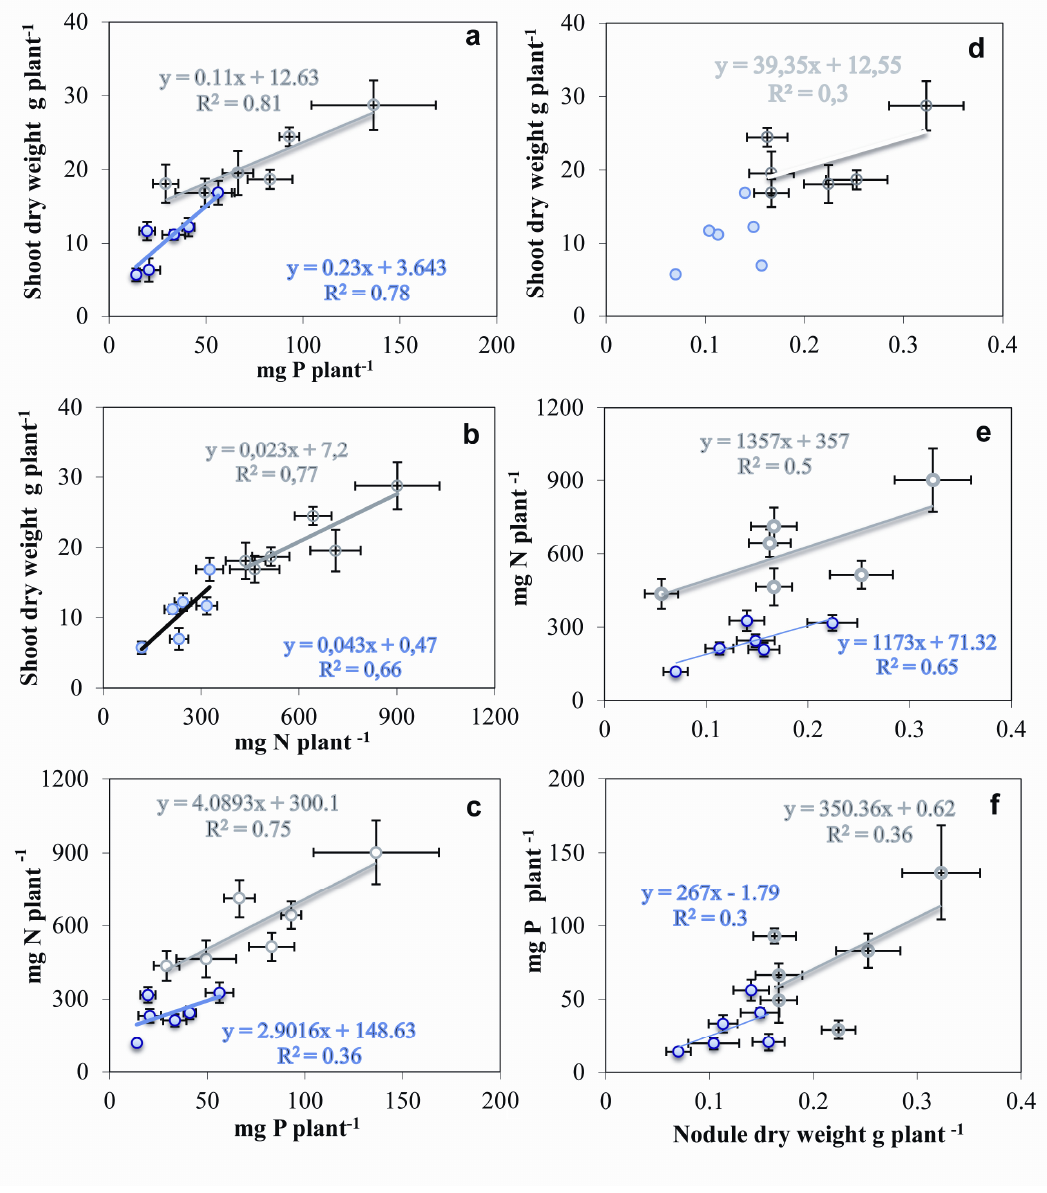
Figure 6. Interactive influence of P, N and nodulation on shoot growth of six common bean genotypes grown under sufficient P (empty square) versus low P (filled square) soil. Data are means ± se of six replicates harvested at flowering